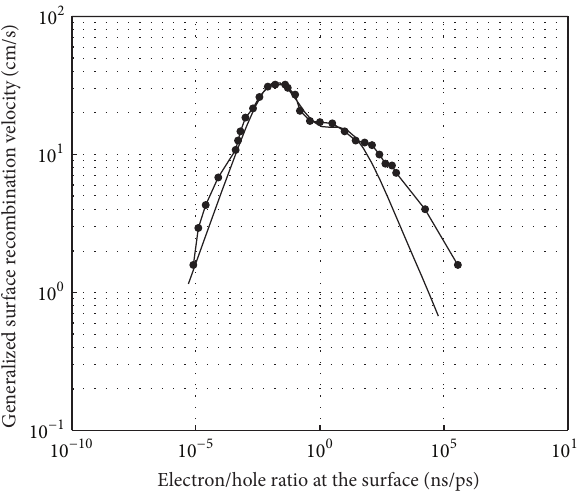
Figure 6: Fitting of experimentally measured surface recombina- = 𝑆 × (Δ𝑛/𝑝) 0.5 versus surface electron/hole tion velocity 𝑆 gen eff concentration ratio 𝑛 𝑠 /𝑝 𝑠 . Circles : experimental results [22], line : results of proposed model.